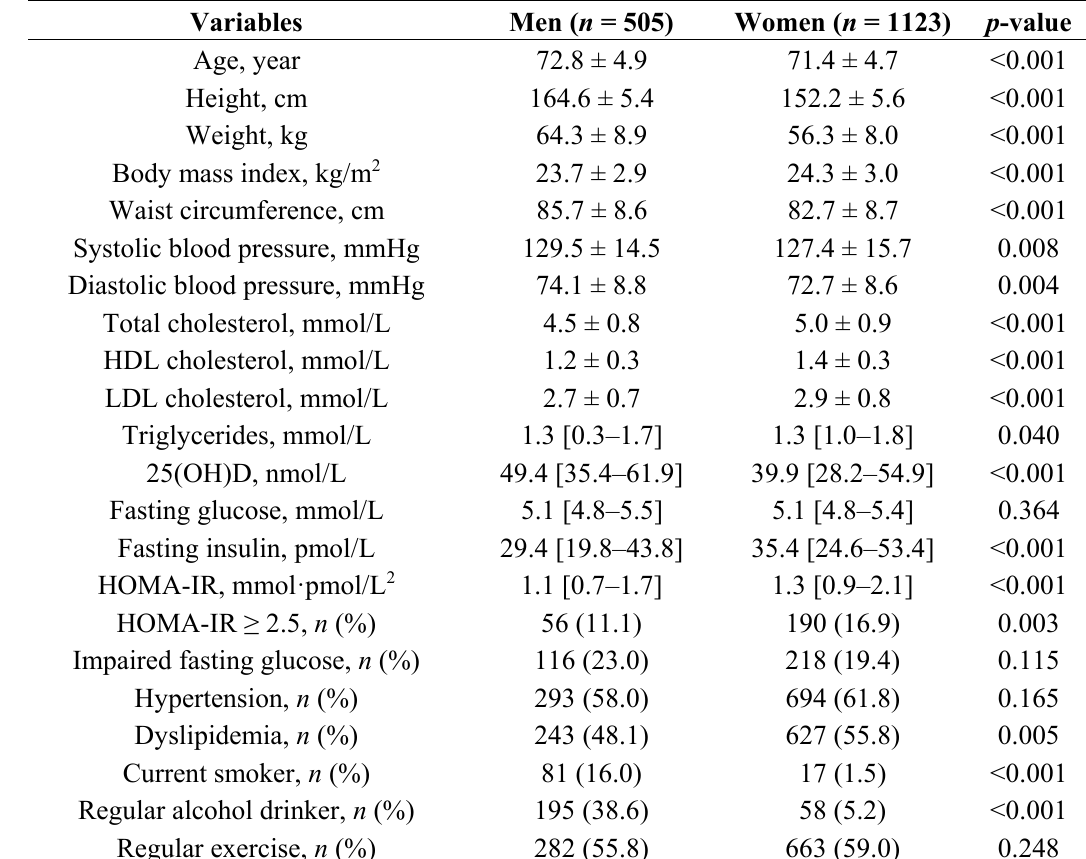
Table 1. General characteristics of the study